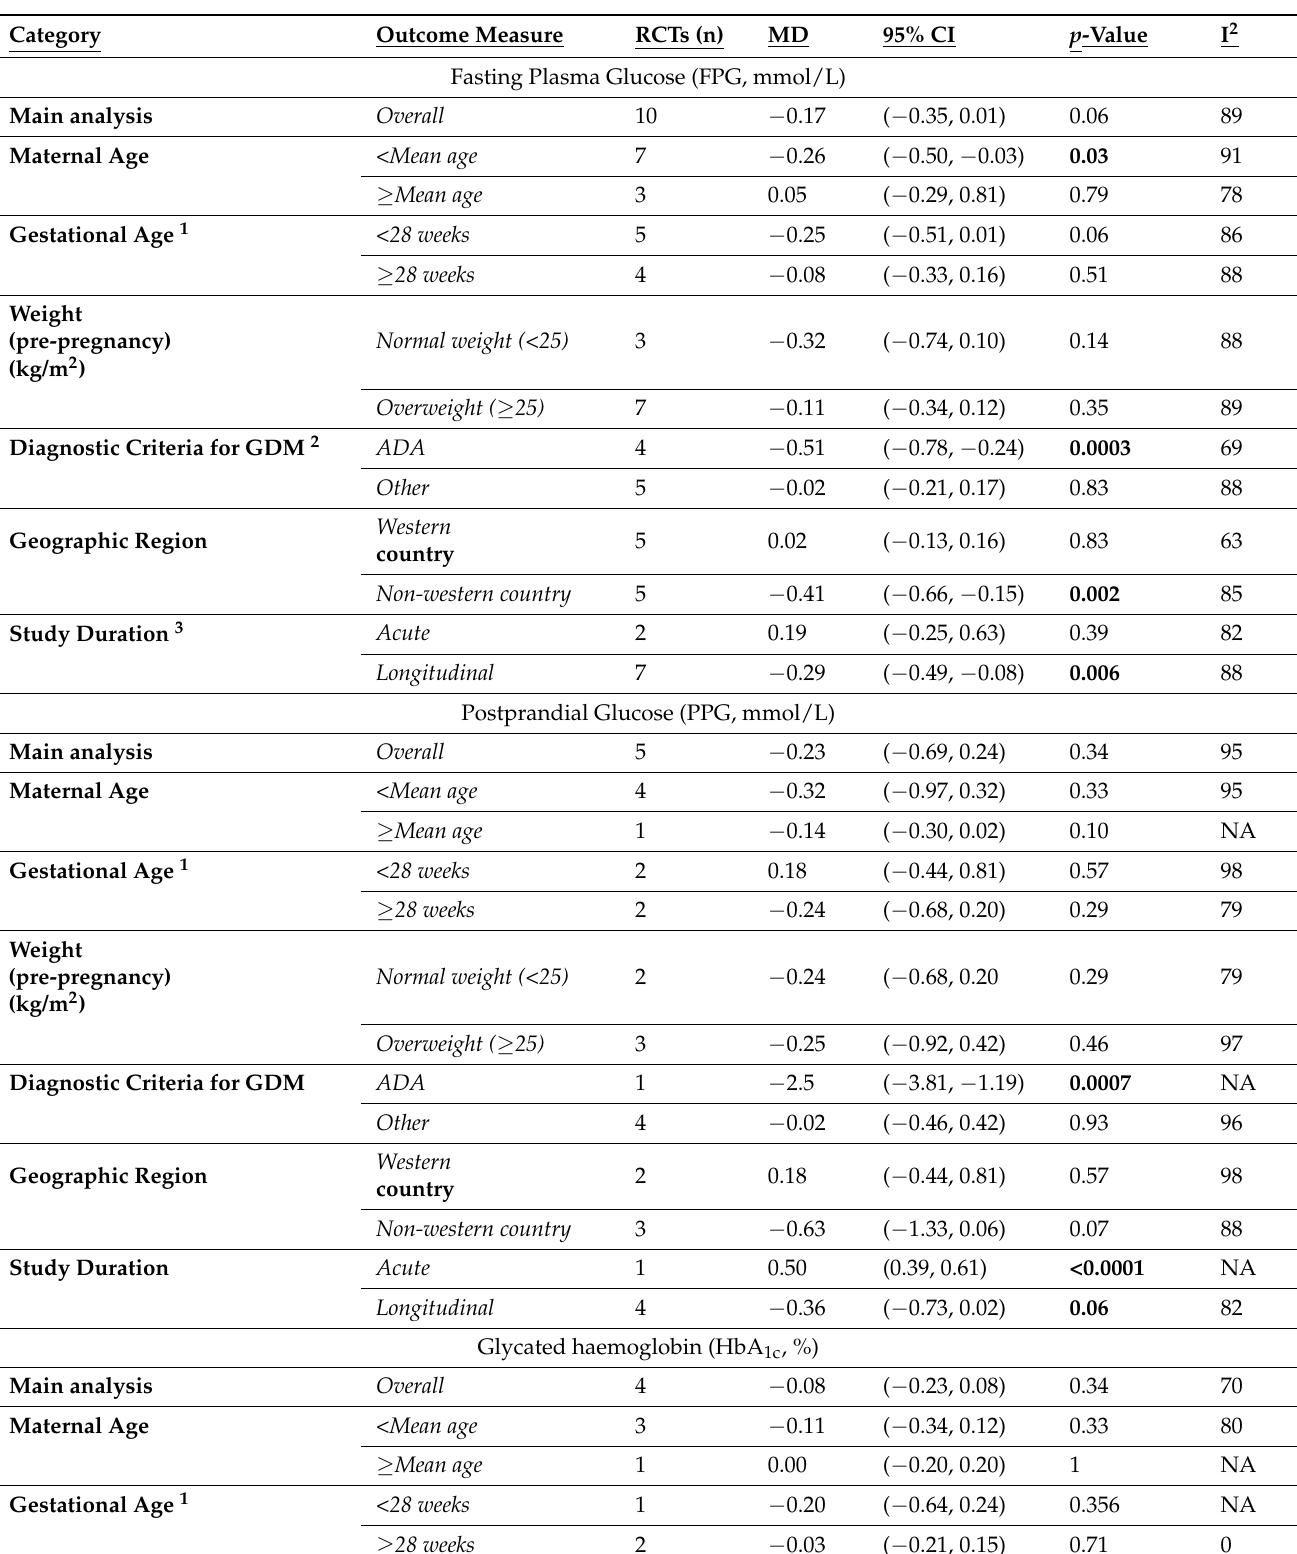
Table 5. Subgroup analysis of dietary vs. control